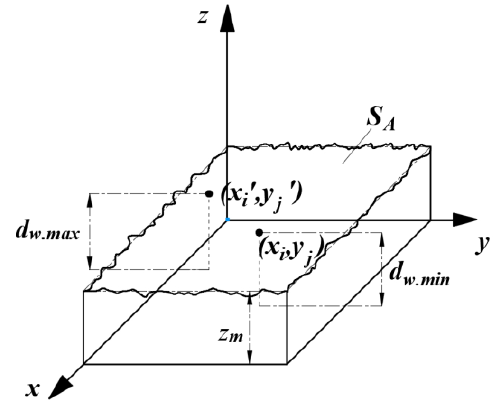
Figure 5. Height of the arbitrary point on the original surface and the average height of the original